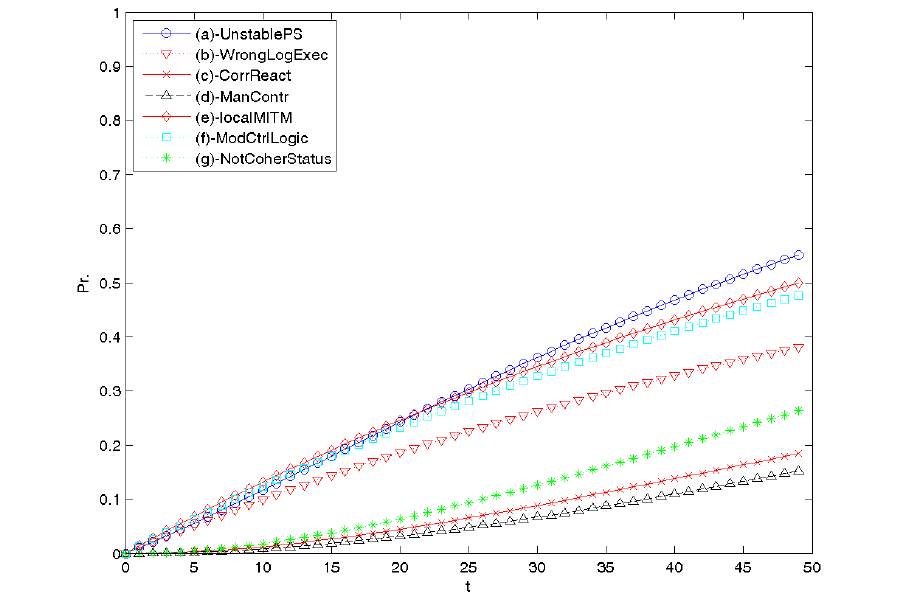
Figure 11. Task: monitoring. For comparison with Figure 10 probabilities of the same events in case of no evidence are